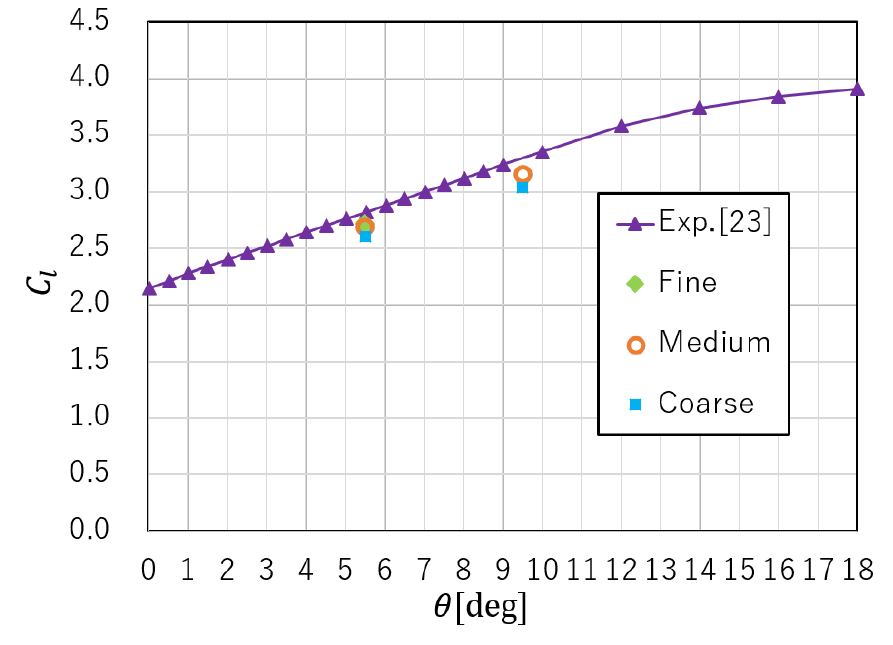
Figure 10. Lift coefficient of the 30P30N high-lift airfoil